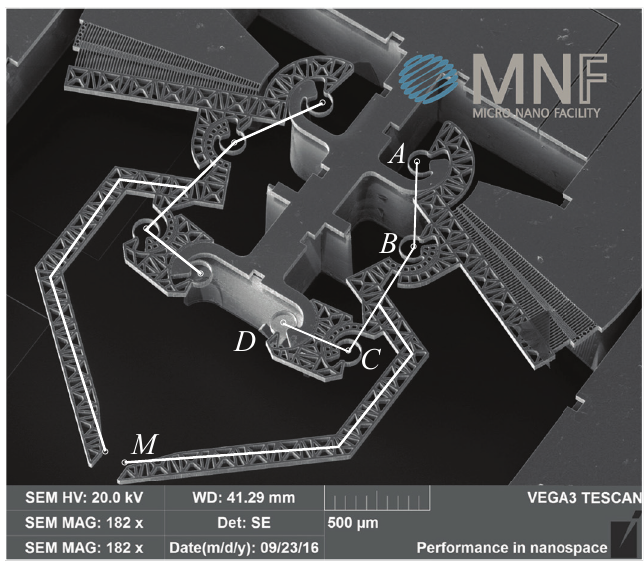
Figure 5. SEM image of a microgripper belonging to the second generation (white solid lines represent two symmetric four-bar linkages, while point M is the coupler